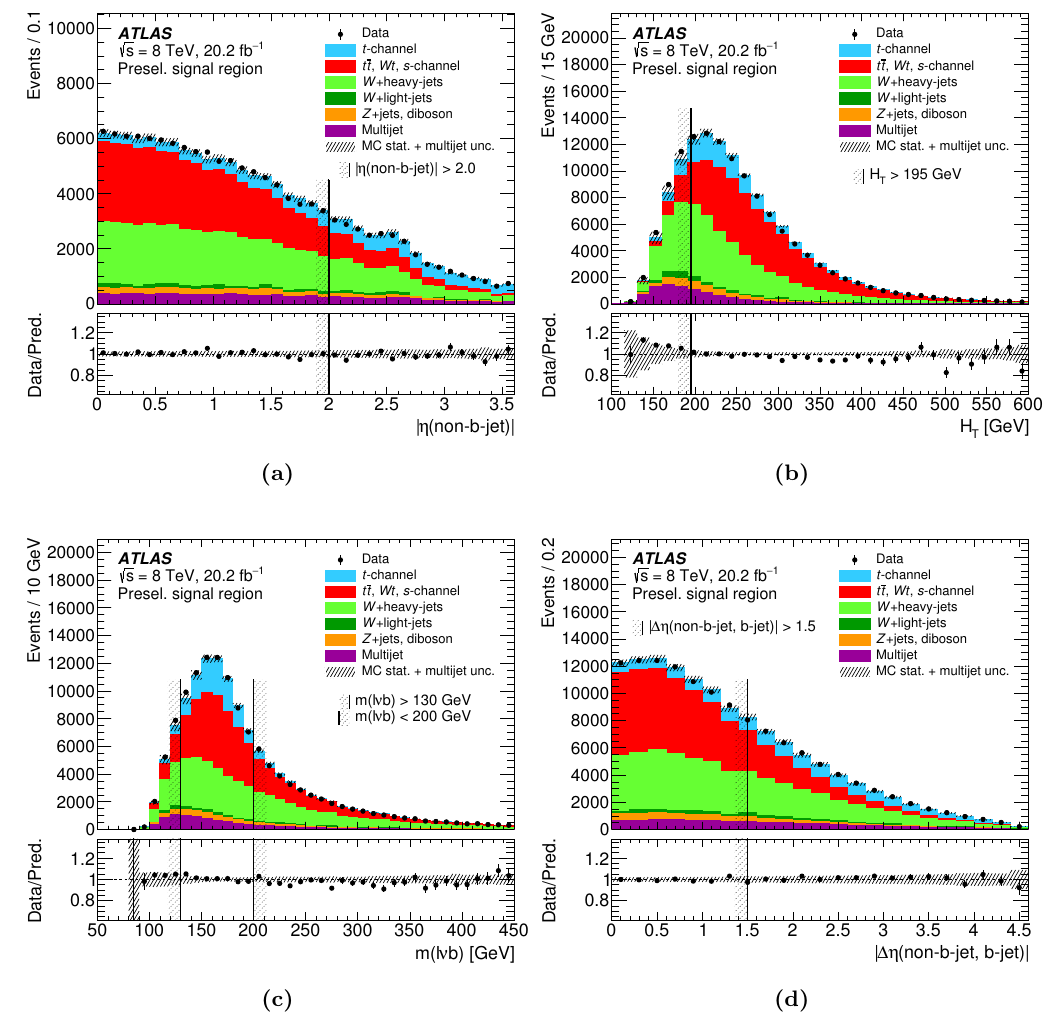
Figure 3. Distributions of (a) (cid:17) (non- b -jet) , (b) the scalar sum of the p T of all (cid:12)nal-state ob- j j jects, H T , (c) reconstructed top-quark mass, m ( ‘(cid:23)b ), and (d) (cid:1) (cid:17) (non- b -jet, b -jet) in the signal j j preselected region for the electron and muon channels merged. The prediction is compared to data, shown as the black points with statistical uncertainties. The multijet background is estimated using data-driven techniques, while contributions from simulated W +jets, top-quark backgrounds and t -channel event samples are normalised to the results of a maximum-likelihood (cid:12)t to event yields in the signal and control regions. The uncertainty bands correspond to the uncertainties due to the size of the simulated event samples added in quadrature with the data-driven normalisation uncertainty of 70% estimated for the multijet contribution. The lower plots show the ratio of data to prediction in each bin. The regions excluded by the selection criteria are shown by vertical black lines and dashed